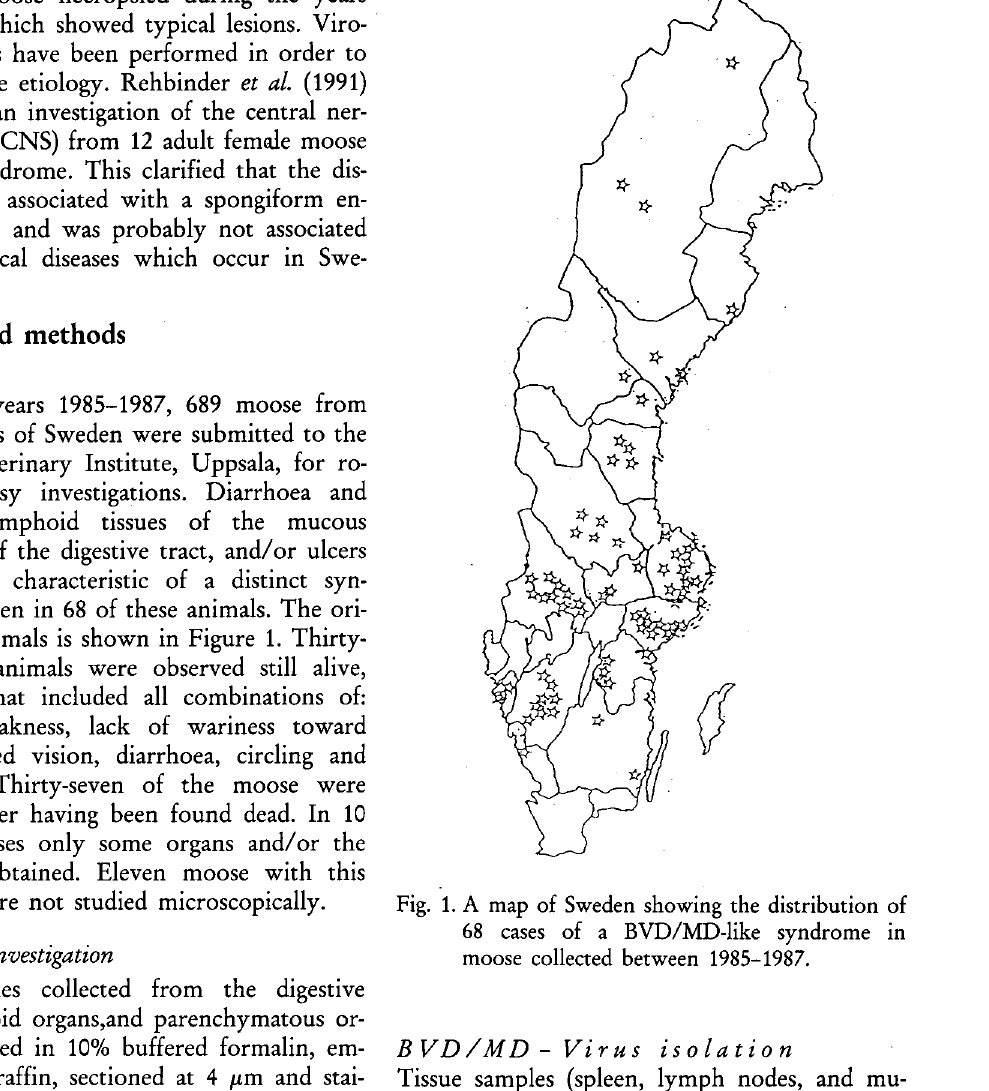
Fig. 1. A map of Sweden showing the distribution of 68 cases of a BVD/MD-like syndrome in moose collected between